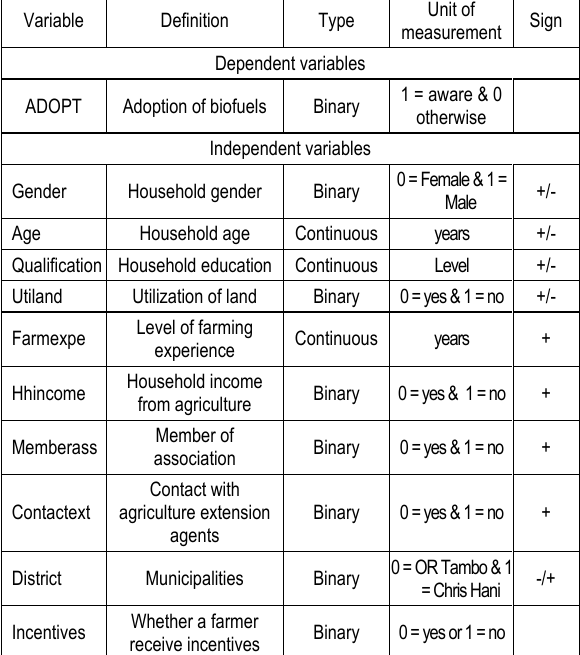
Table 2. Variables used in the study